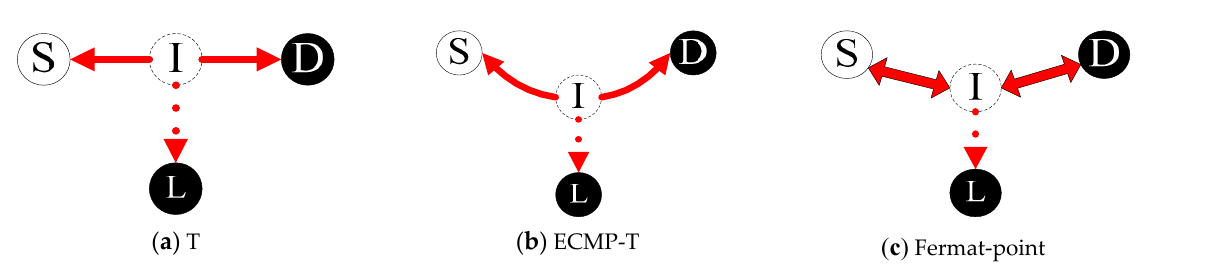
Figure 2. Legacy interception models.